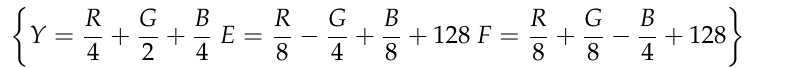
Figure 3. Equivalent distribution of pixels in YEF color space. The proposed study selects the 4:2:0 sampling format to sample E and F color space, which can achieve a higher compression rate. The 4:2:0 sampling is to discard half of the vertical and horizontal pixels of the image. Hence, there are many different 4:2:0 sampling positions. For different sampling positions, the image quality results are not the same. One is to consider whether E and F are sampled in the same position, and the other is whether E and F are sampled in the same vertical direction. This study takes the 4:2:0 sampling positions as shown in Figure 4. Figure 4. Four types of 4:2:0 sampling format. 2.2. BTC Algorithm and Threshold Optimization The BTC algorithm [21] has a lower complexity than the traditional BTC or AMBTC algorithm, which can save hardware costs. In view of this, this research proposes a more advanced threshold optimization, the BTC algorithm. This method not only maintain the image compression rate, but also improves the image quality. A bitmap is binary infor- mation. The threshold in the traditional BTC algorithm is the average of the blocks uti- lized. The conversion formulas are shown in Equations (4) and (5): 𝐵𝑀(𝑖, 𝑗) = {1, 𝑖𝑓 𝑋(𝑖, 𝑗) > 𝑎𝑣𝑒𝑟𝑎𝑔𝑒 0, 𝑜𝑡ℎ𝑒𝑟𝑤𝑖𝑠𝑒 (4) where the current pixel value is X ( i , j ),and BM ( i , j ) is the result of binary from X ( i , j ).